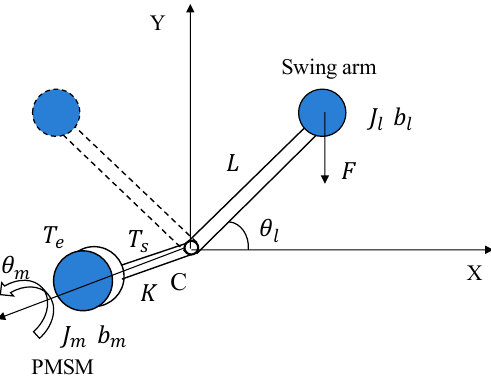
Figure 2. Dual-mass models of the robot joint.